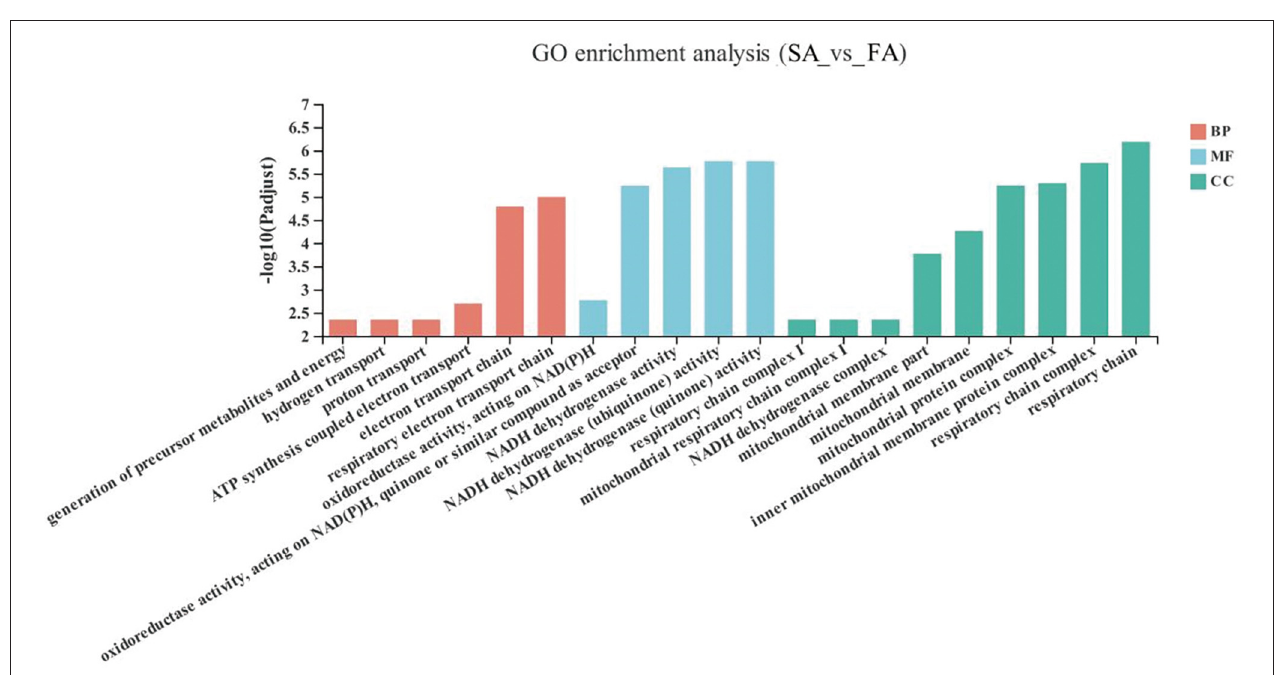
Frontiers in Veterinary Science |